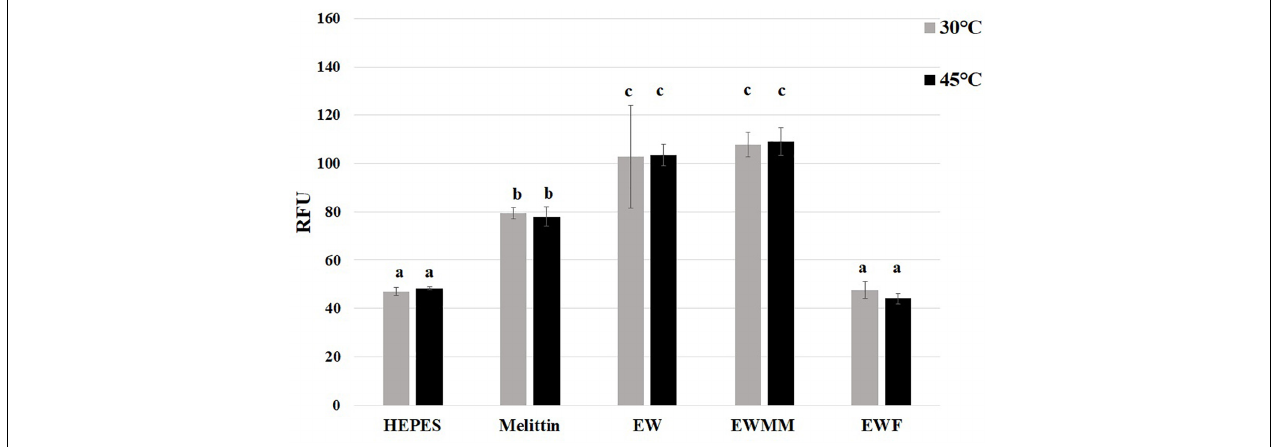
FIGURE 4 | Effect of EW proteins on the membrane depolarization of S. Enteritidis. S . Enteritidis cells were charged with diSC 3 (5) dye and incubated at 30 or 45 ◦ C in Hepes (negative control, 5 mM pH 7.2), melittin (positive control, 15 µ g/mL in 5 mM Hepes, pH 7.2) and EW, EWMM, or EWF at pH 9.3. Results are shown as means of relative fluorescence units (RFU) of triplicate experiments with standard deviations. Results obtained under the conditions indicated were compared using analysis of variance and the average comparison test using the R software. Letters were used to identify average significantly different ( p ≤